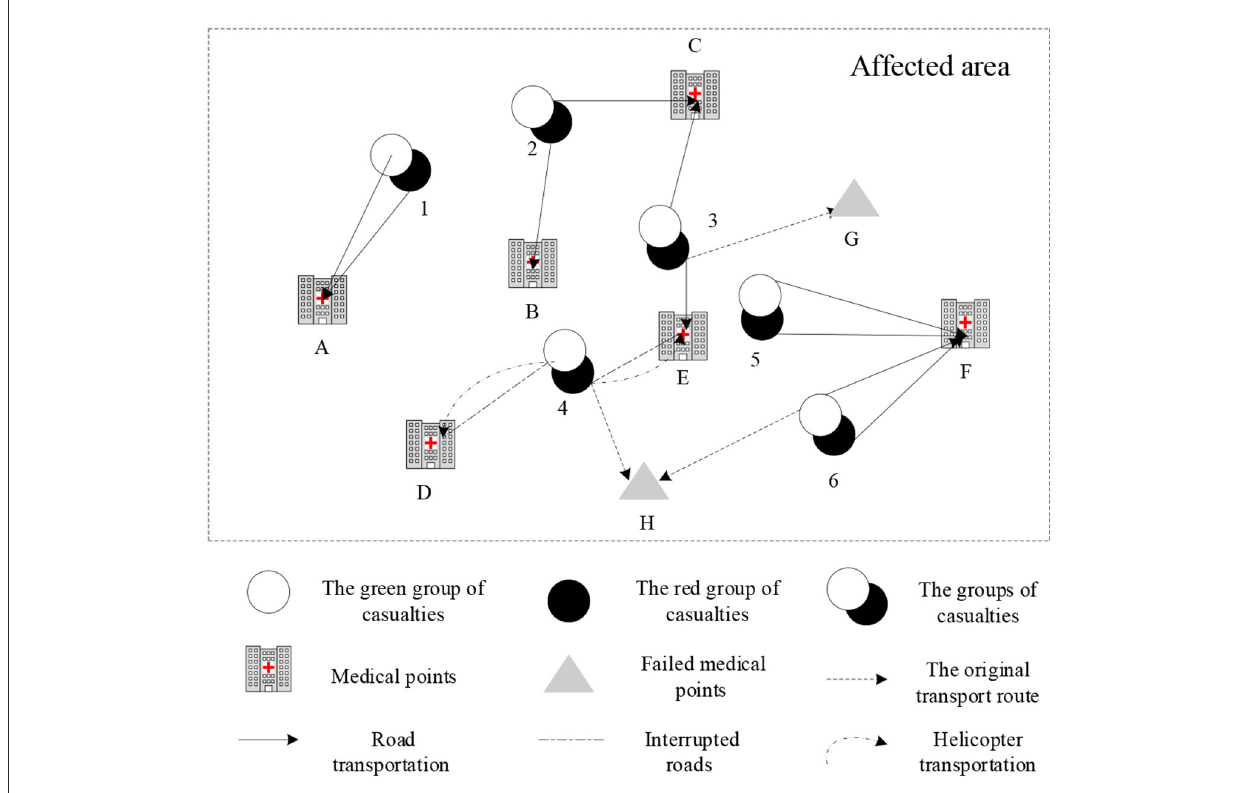
FIGURE2 Transport network diagram in the early stage of post-earthquake